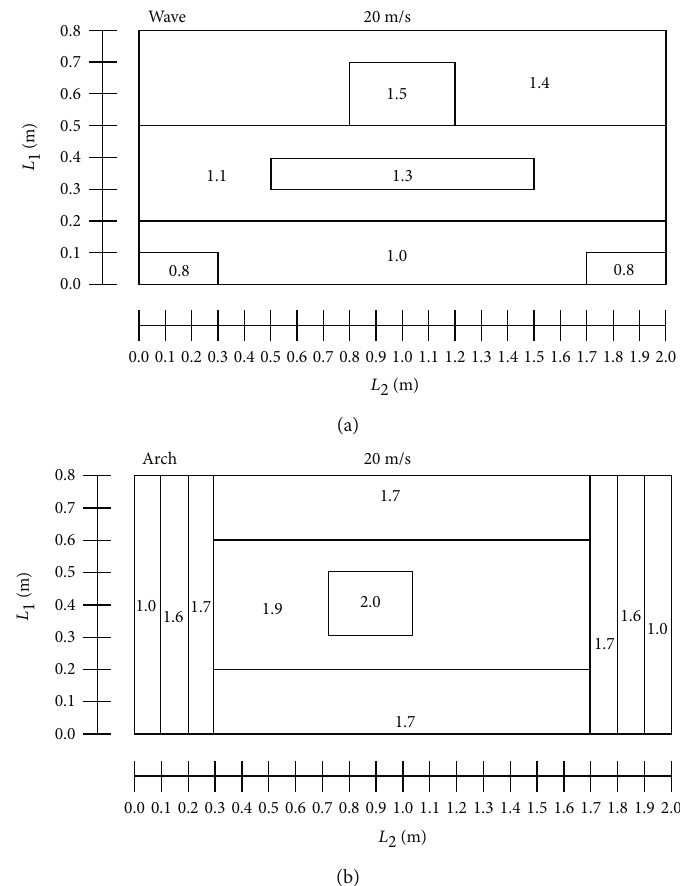
Figure 8: Partition diagrams of the wind pressure coe ffi cients of the wave and arch roof at the same wind speed, v = 20 m/s (a, b). L is the length of the model, the unit is width of the model and L 2